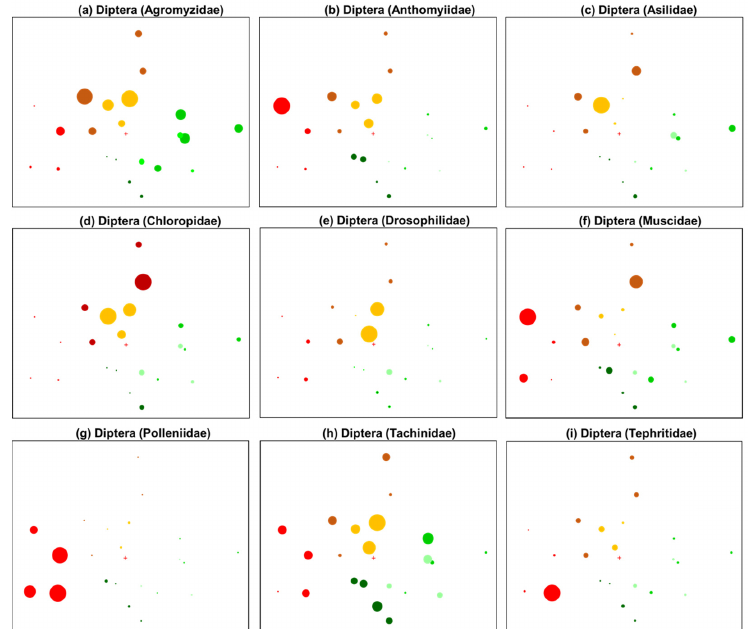
Figure 8. NMDS ordination results for fire-adapted Diptera in burn and reference study sites. Panels ( a – i ) show results for Diptera Families; ( a ) Agromyzidae, ( b ) Anthomyiidae, ( c ) Asilidae, ( d ) Chloropidae ( e ) Drosophilidae ( f ) Muscidae ( g ) Polleniidae, ( h ) Tachinidae ( i ) Tephritidae. Symbol size is scaled by percent abundance within each sample.